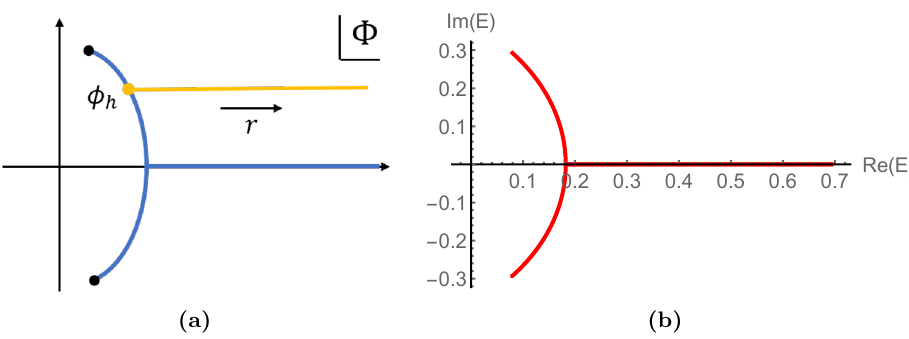
Figure 16. (a) On the Φ complex plane, the blue curve is the locus for which W (Φ) ∈ R , and φ h is valued on this curve. For a given solution, Φ takes value on the yellow straight line emanating from φ h , which is parameterized by radial coordinate r ∈ [0 , + ∞ ) . (b) The support γ ∗ of energy spectrum on complex E plane. It has two branches γ ∗ , ± conjugate to each